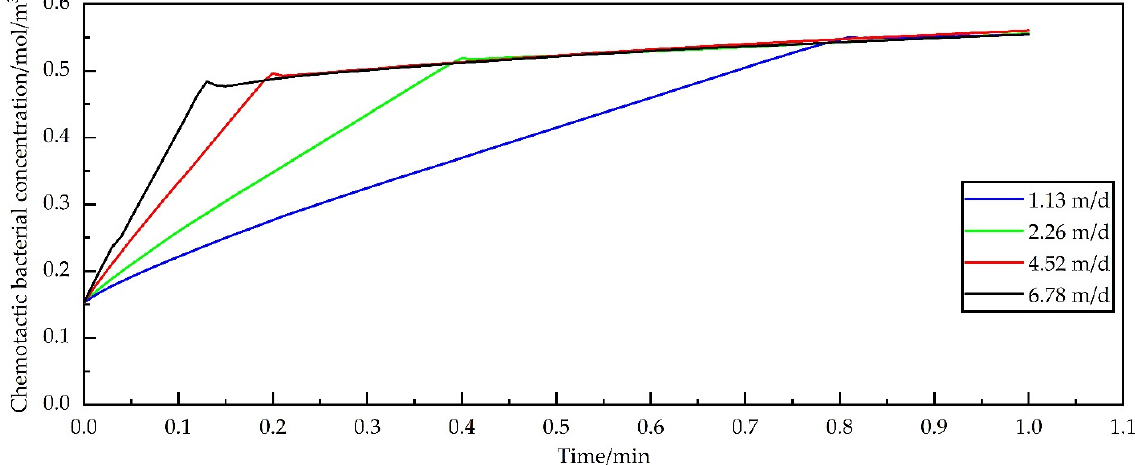
Figure 11. Average concentration of chemotactic bacteria with time at different flow rates.